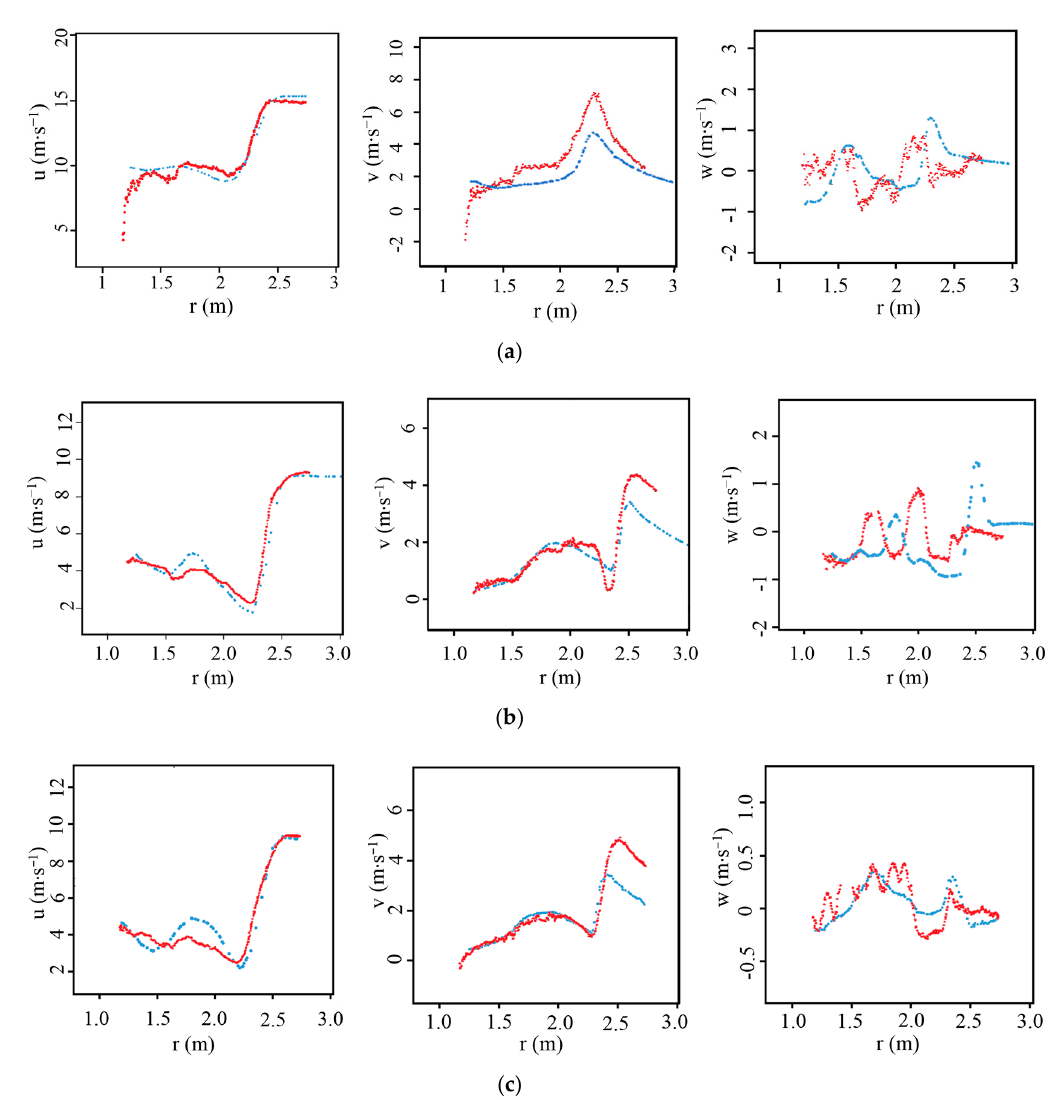
Figure 9. Validation of the radial traverse at x = 0.30 m, showing comparison between computational and experimental data for ( a ) U = 15 m ∙ s − 1 ; ( b ) Free ‐ Stream Velocity U = 10 m ∙ s − 1 ; ( c ) Free ‐ Stream Velocity U = 10 m ∙ s − 1 for Azimuth = 100°. The blue lines represent the computational data and the red lines represent MEXICO rotor experimental data.